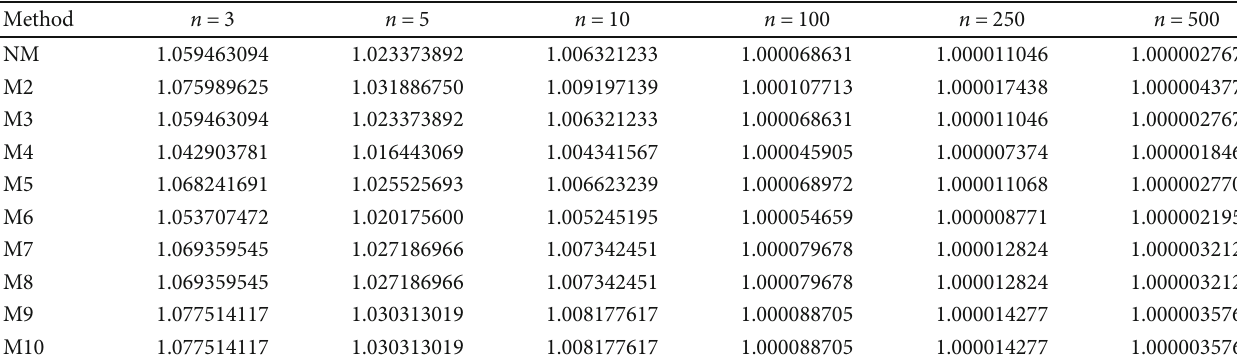
Table 21: Values of EI for methods in the fi rst category to solve Test Problem 1, and n = 3, 5, 10,100,250,500 . Method